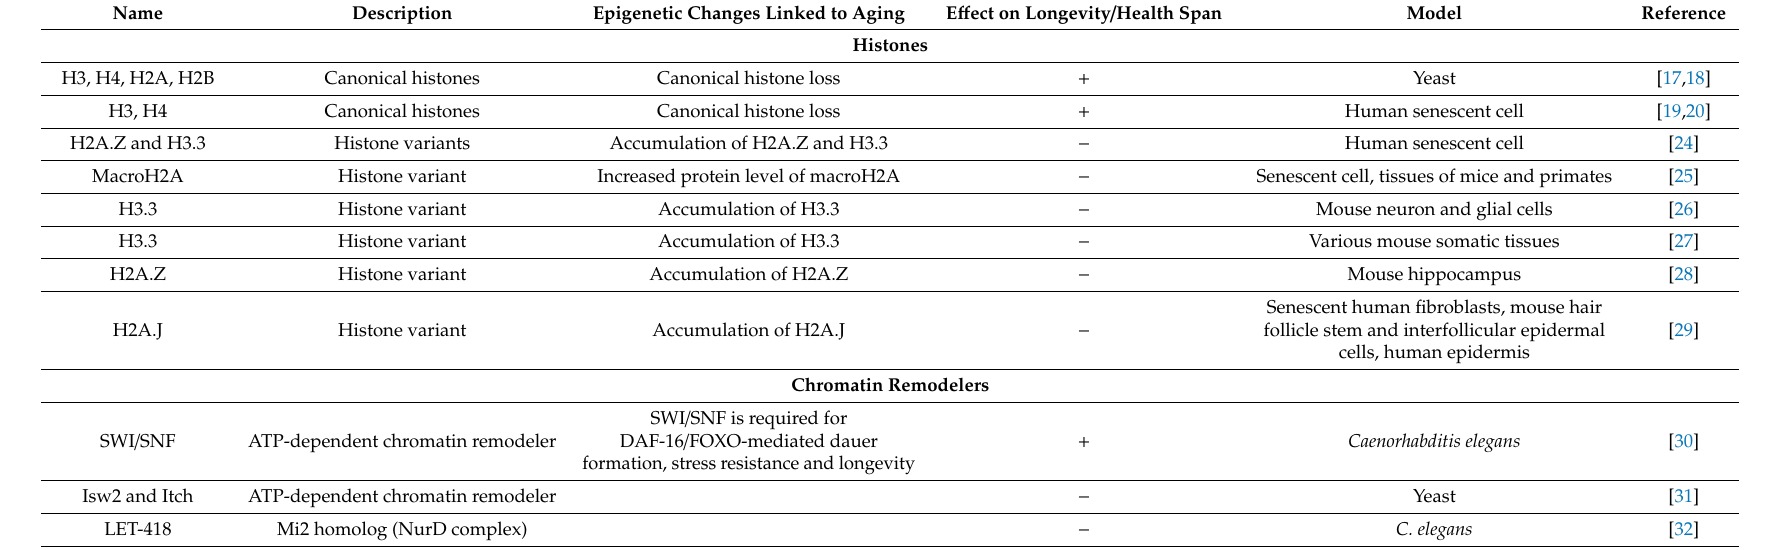
Table 1. Modulation of histones and chromatin remodelers during